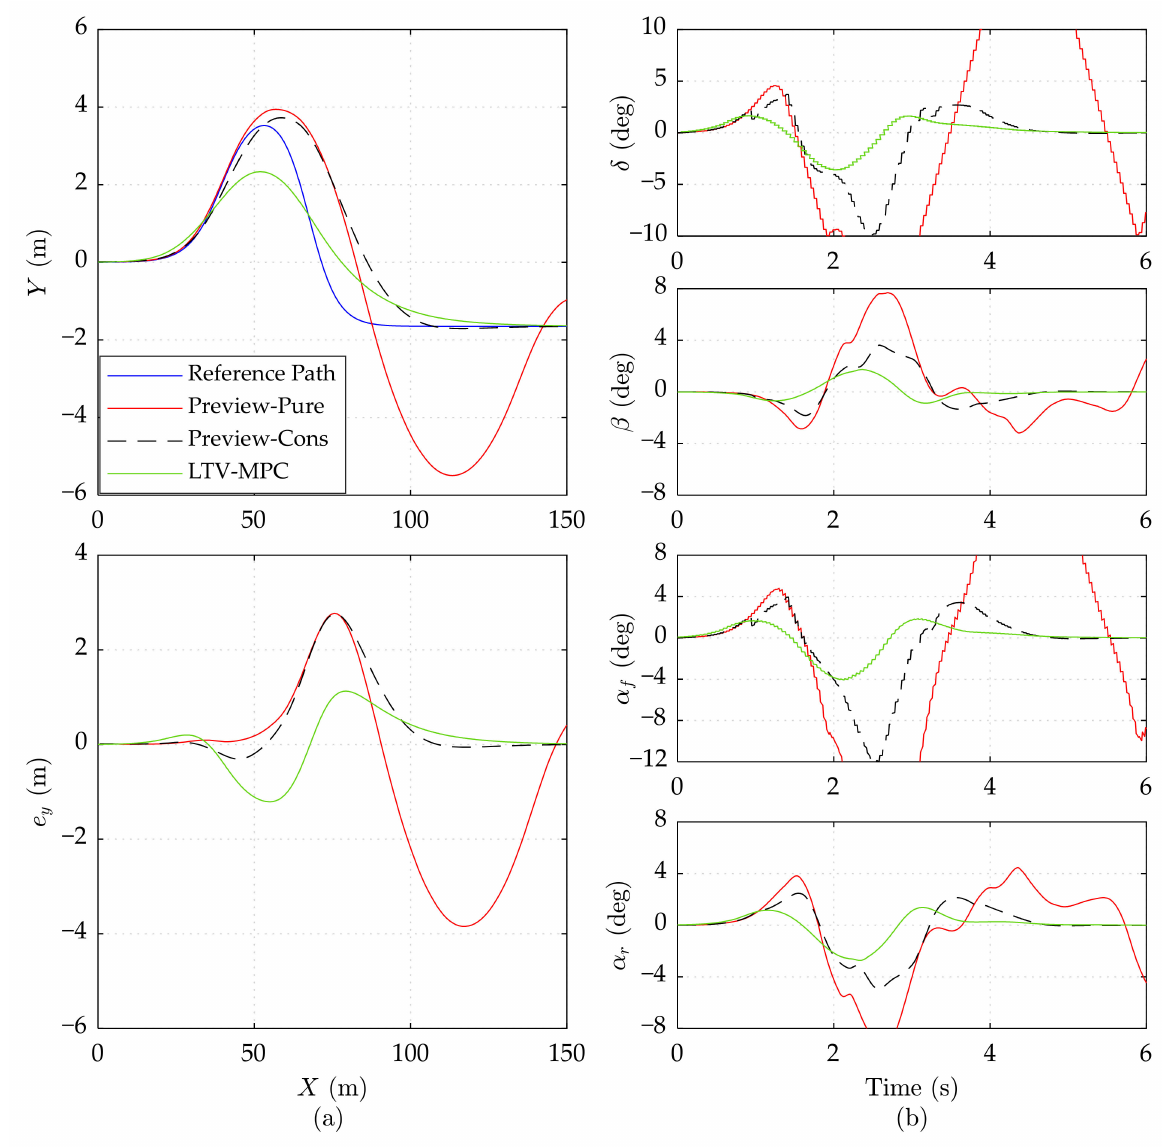
Figure 6. Simulation results of three controllers on the high adhesion road at 25 m/s speed. ( a ) Vehicle driving trajectory, lateral error e y . ( b ) Front wheel steering angle δ , mass center slip angle β , front wheel slip angle α f , and rear wheel slip angle α r . The results of Preview-Pure beyond range are cut